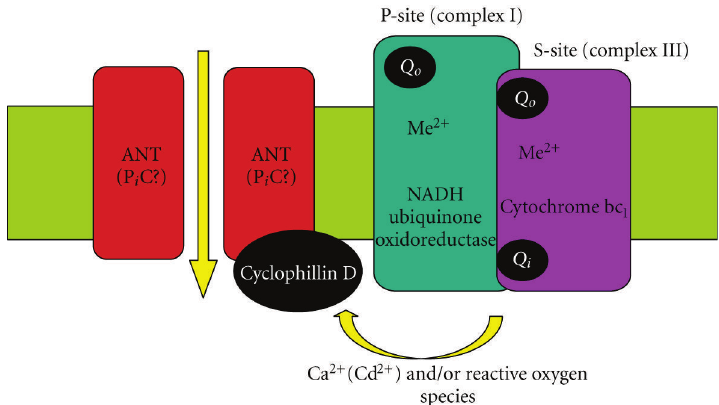
Figure 4: A hypothetical model of mitochondrial permeability transition pore structure: an involvement of a mitochondrial super-complex formed by respiratory chain complexes I and III (modified from [48, 49], see explanation in